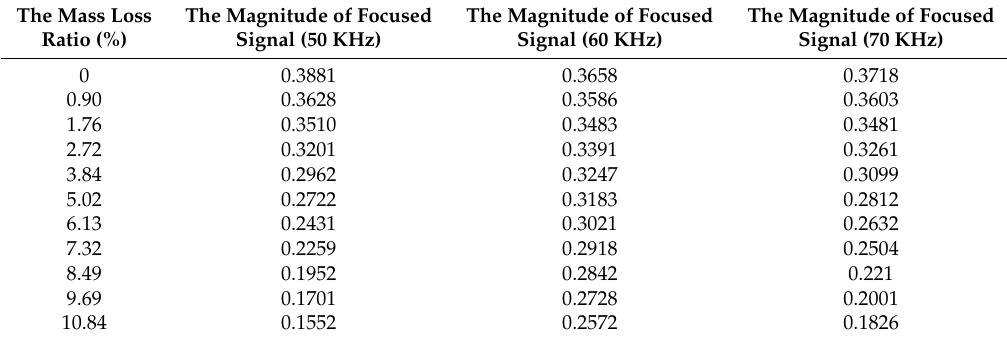
Table 4. The data of specimen no. 4.